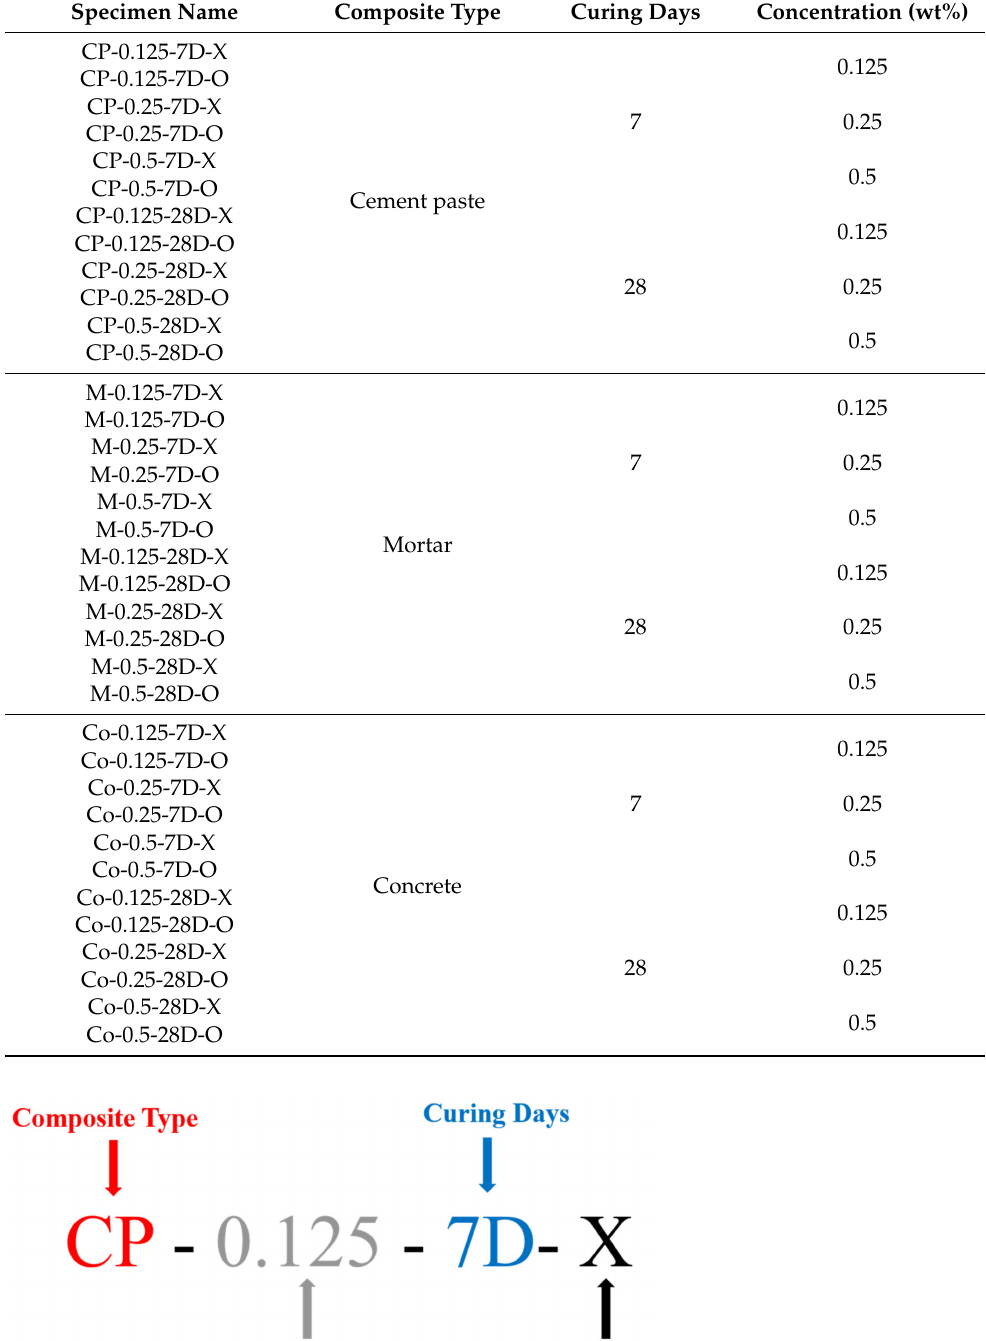
Table 1. Parameters of cement composite temperature tests.